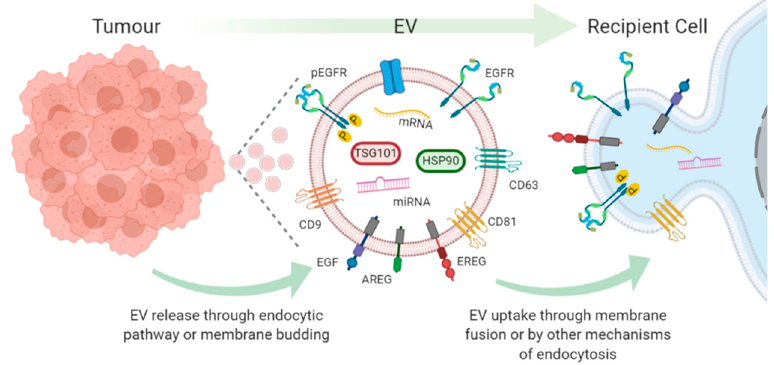
Figure 1. Tumour release of EVs containing EGFR monomers, phosphorylated EGFR (pEGFR), EGFR ligands; epidermal growth factor (EGF), amphiregulin (AREG), epiregulin (EREG) and subsequent uptake and transfer of cargo in recipient cell.